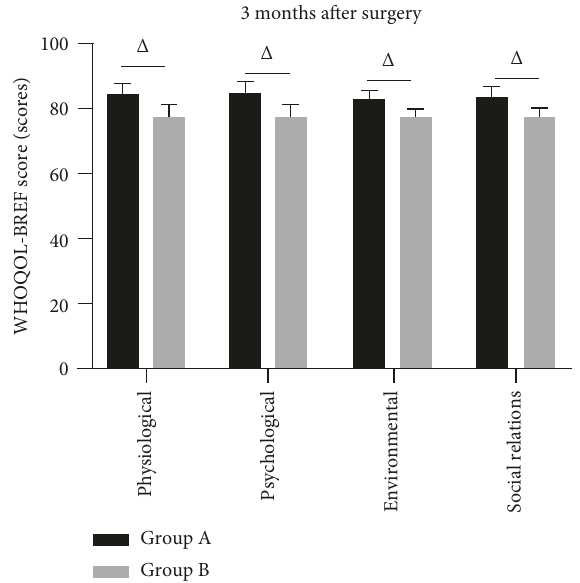
Figure 12: WHOQOL-BREF score at 3 months after surgery. Note . Δ indicates P < 0 . 05 for the difference between groups A and B. Table 2: Clinical efficacy in groups A and B ( n ,%).